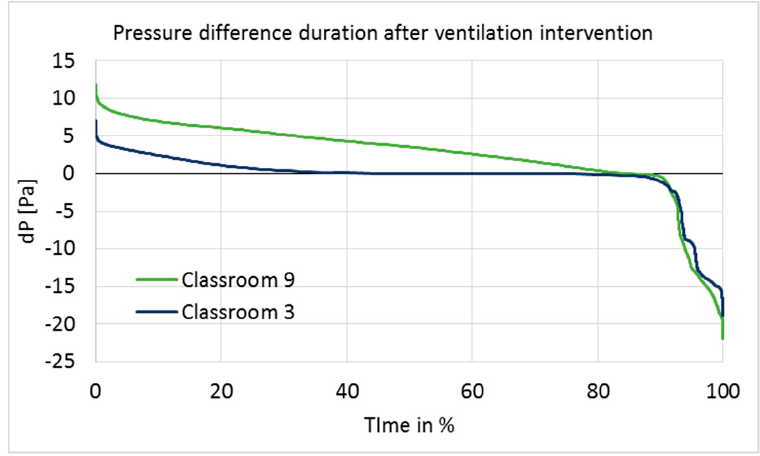
Figure 4. Duration of pressure differences across the envelope in Classrooms 3 and 9 during nine months after ventilation intervention.